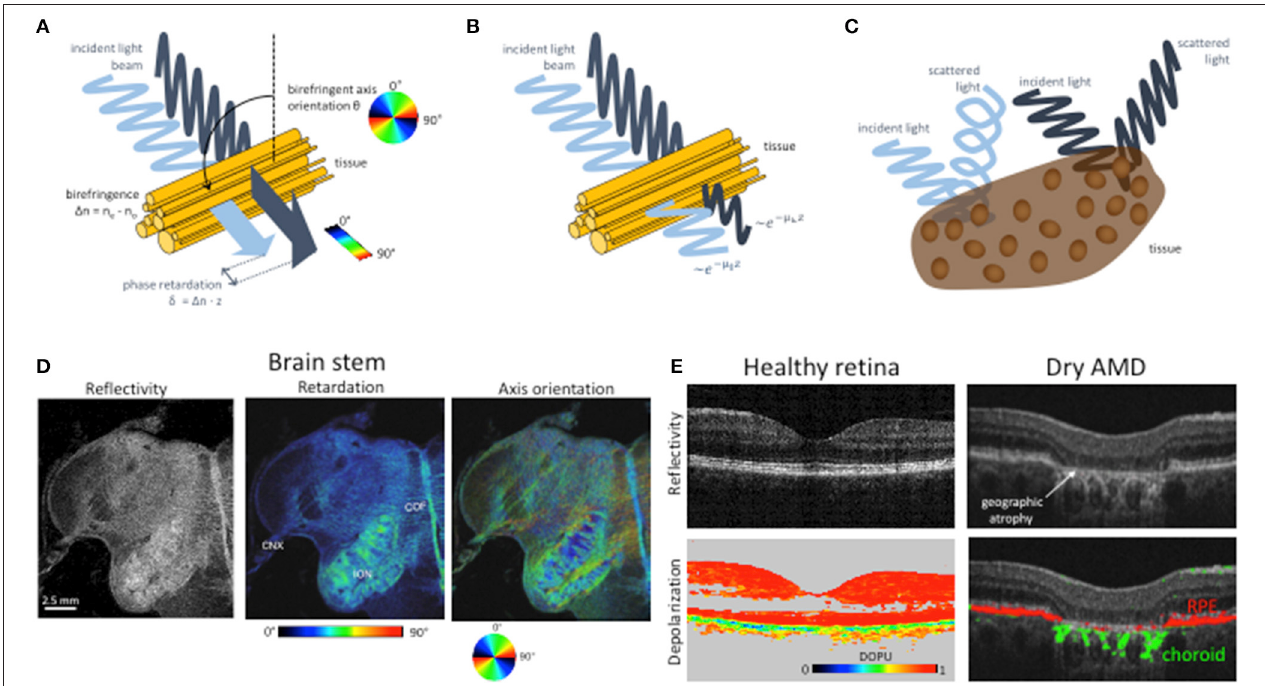
FIGURE 4 | Imaging tissue with polarization contrast using PS OCT. (A) Cartoon of birefringence in fibrous tissue. Light polarized parallel and perpendicular to the birefringent axis propagates at different speeds. The accumulated relative phase retardation δ as well as the birefringent axis orientation θ can be measured by PS-OCT. (B) Diattenuation. The two polarization components are subject to different attenuation characteristics. (C) Depolarization. The polarization state of scattered light is scrambled in some tissues, e.g., in such containing melanin pigments. (D) PS OCT imaging of a human brain stem. The reflectivity image (left) displays the intensity of backscattered light. Birefringent structures such as the vagus nerve (cranial nerve X, CNX,) and the cerebelloolivary fibers (COF) exhibit increased retardation values (right). In the axis orientation image (right), the orientation of fiber tracts—e.g., in the inferior olivary nucleus (ION)—is shown in different colors as per the color wheel below. Modified from [ 46] with permission from SPIE. (E) PS OCT imaging of depolarization in the human retina. The healthy retina on the left shows a regular layered structures and strong depolarization in melanin-laden tissues such as the RPE. In late-stage dry AMD, the layered structure is destroyed in the macula. In the atrophic zone, the interrogating OCT beam can penetrate deep into the choroid. The pigmented and hence depolarizing RPE and choroid are displayed in red and green, respectively. Modified from Baumann et al. [ 47] with permission from